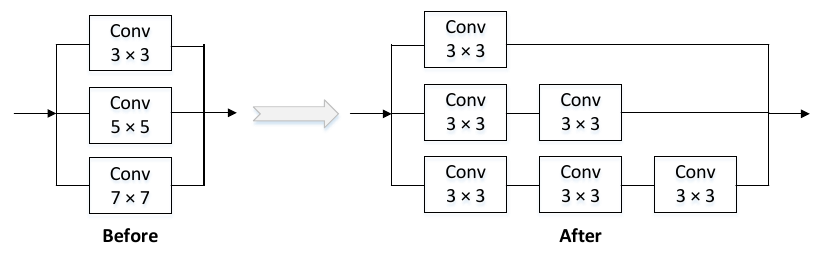
Figure 6. The structure of